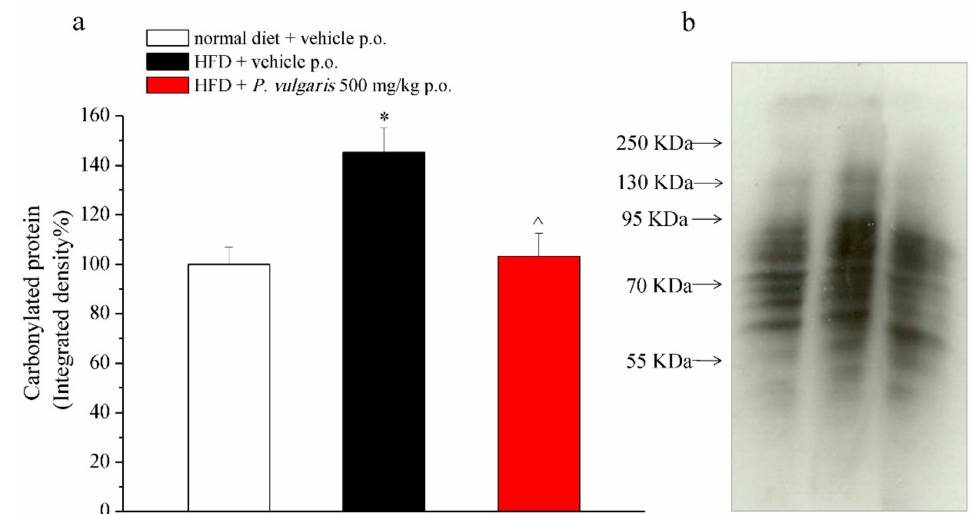
Figure 3. Plasmatic oxidation. E ff ects of HFD and treatments on the levels of carbonylated proteins in plasma (week 19). Protein oxidative damage was quantified by immunoblot. ( a ) Densitometric analysis and ( b ) representative Western blot are shown. Ponceau-stained membranes were used as loading control. Results are expressed as % of control group (normal diet + vehicle; 100%). Each value represents the mean ± S.E.M. of 12 mice per group. * p < 0.05 vs. normal diet + vehicle; ˆ p < 0.05 vs. HFD +